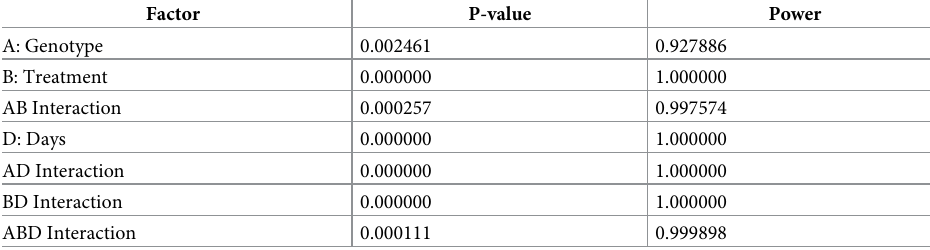
Table 3. UV-induced skin thickening in hairless Adrb2 knockout mice three-way repeated measures ANOVA